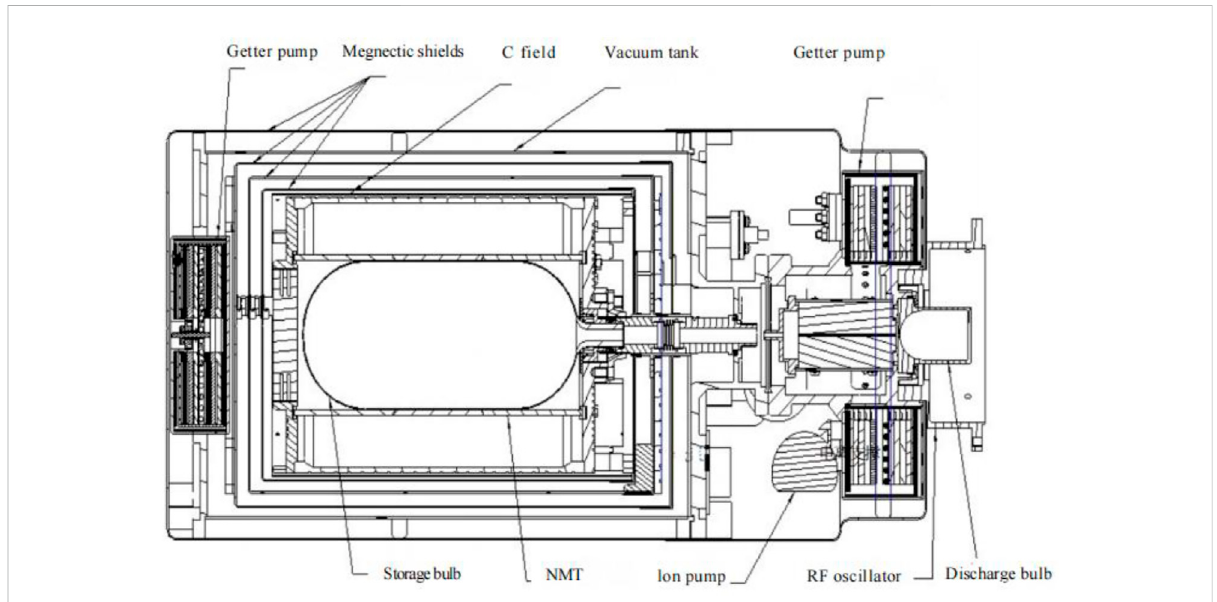
FIGURE 5 Physics design based on NMT-loaded cavity. Physics package has four magnetic shielding layers and two getter pumps combined with the ion pump maintains the vacuum in the hydrogen atomic beam formation system and vacuum in the RF